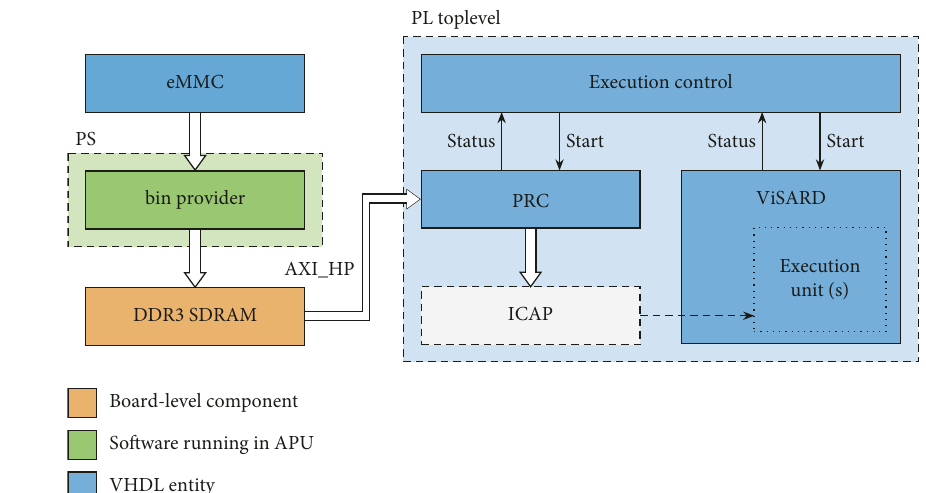
Figure 6: Structure of the custom DPR